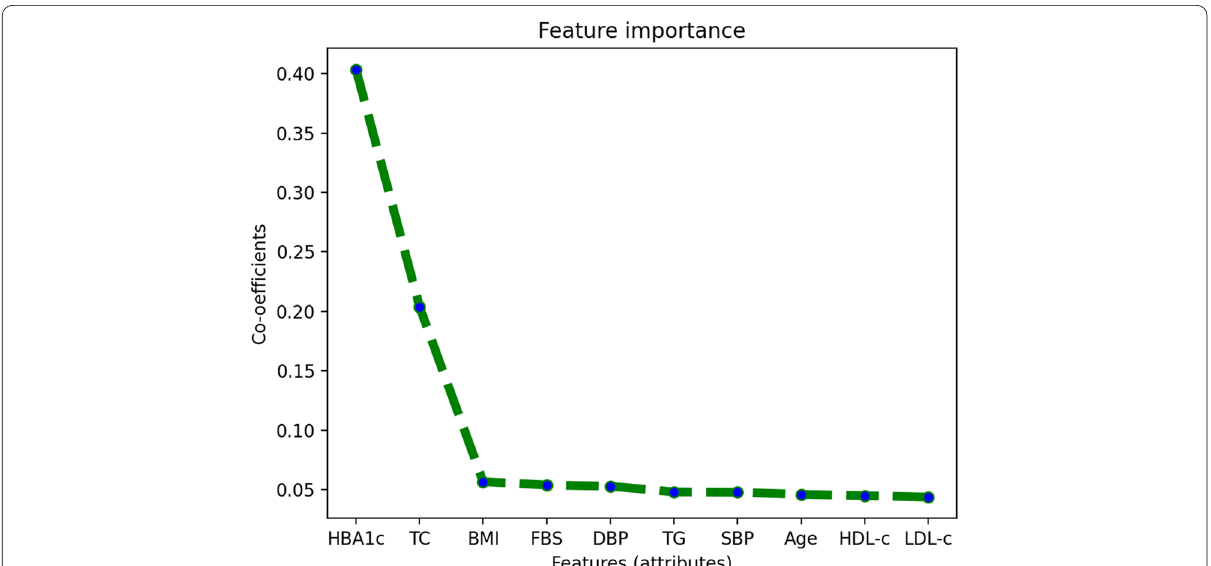
Fig. 7 Feature importance across four machine learning algorithms. Glycated haemoglobin (HbA1c), Total cholesterol (Chol); Body Mass Index (BMI); Fasting Blood Sugar (FBS); Diastolic Blood Pressure (DBP); Triglycerides (TG); Systolic Blood Pressure (SBP); High Density Lipoprotein cholesterol (HDL‑c); Density Lipoprotein cholesterol